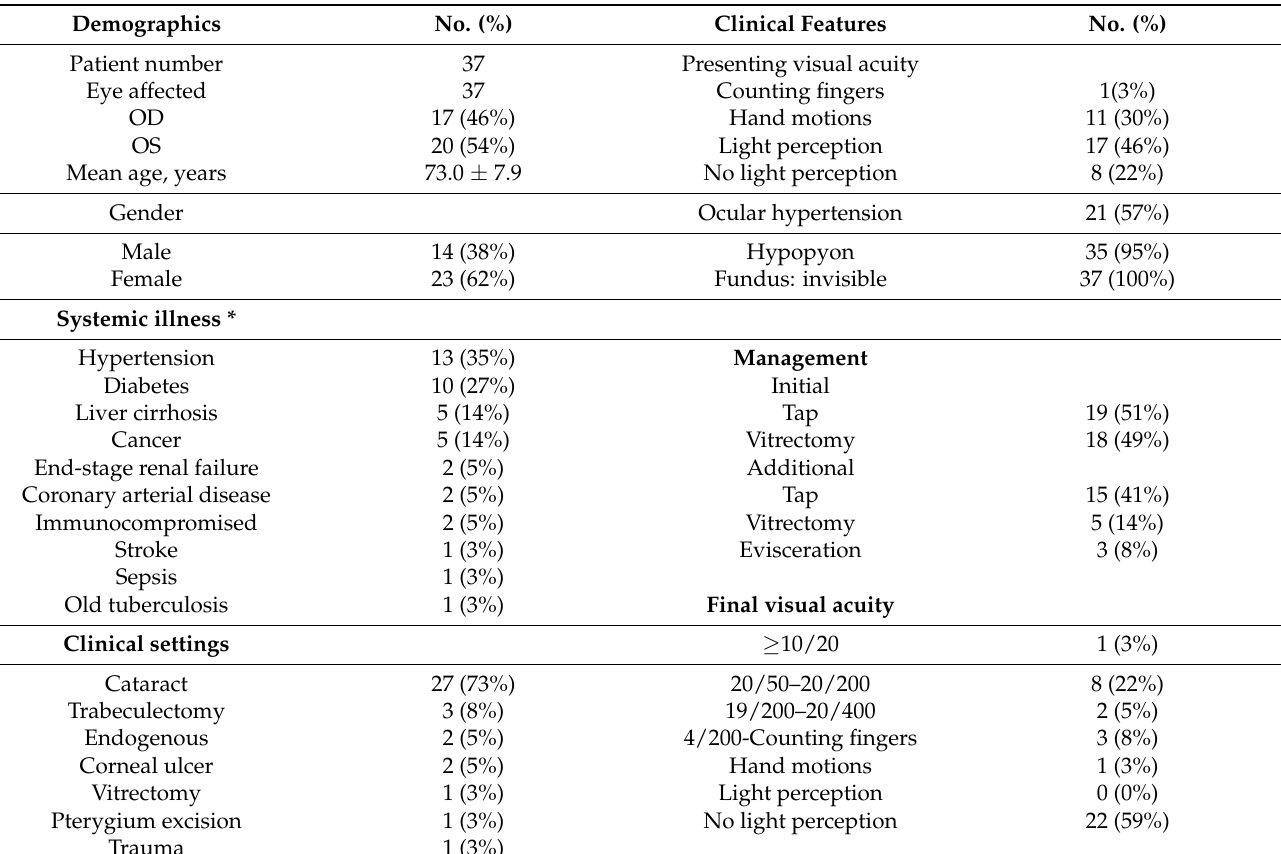
Table 1. Demographics, Clinical Settings and Features, Managements, and Outcomes of Patients with Enterococcus faecalis